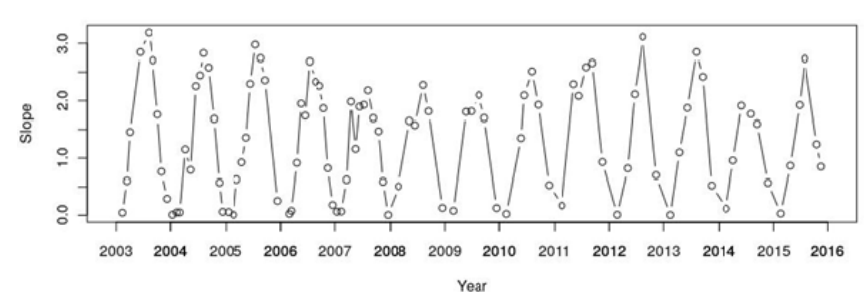
Figure A2. Thermocline maximum slopes (°C/m) calculated for Lake Varese, from 2003 to 2015. Table A1. Total phytoplankton community expressed as cell density (cells/L) and biovolume (mm 3 /m 3 ) for the period 2004–2014.